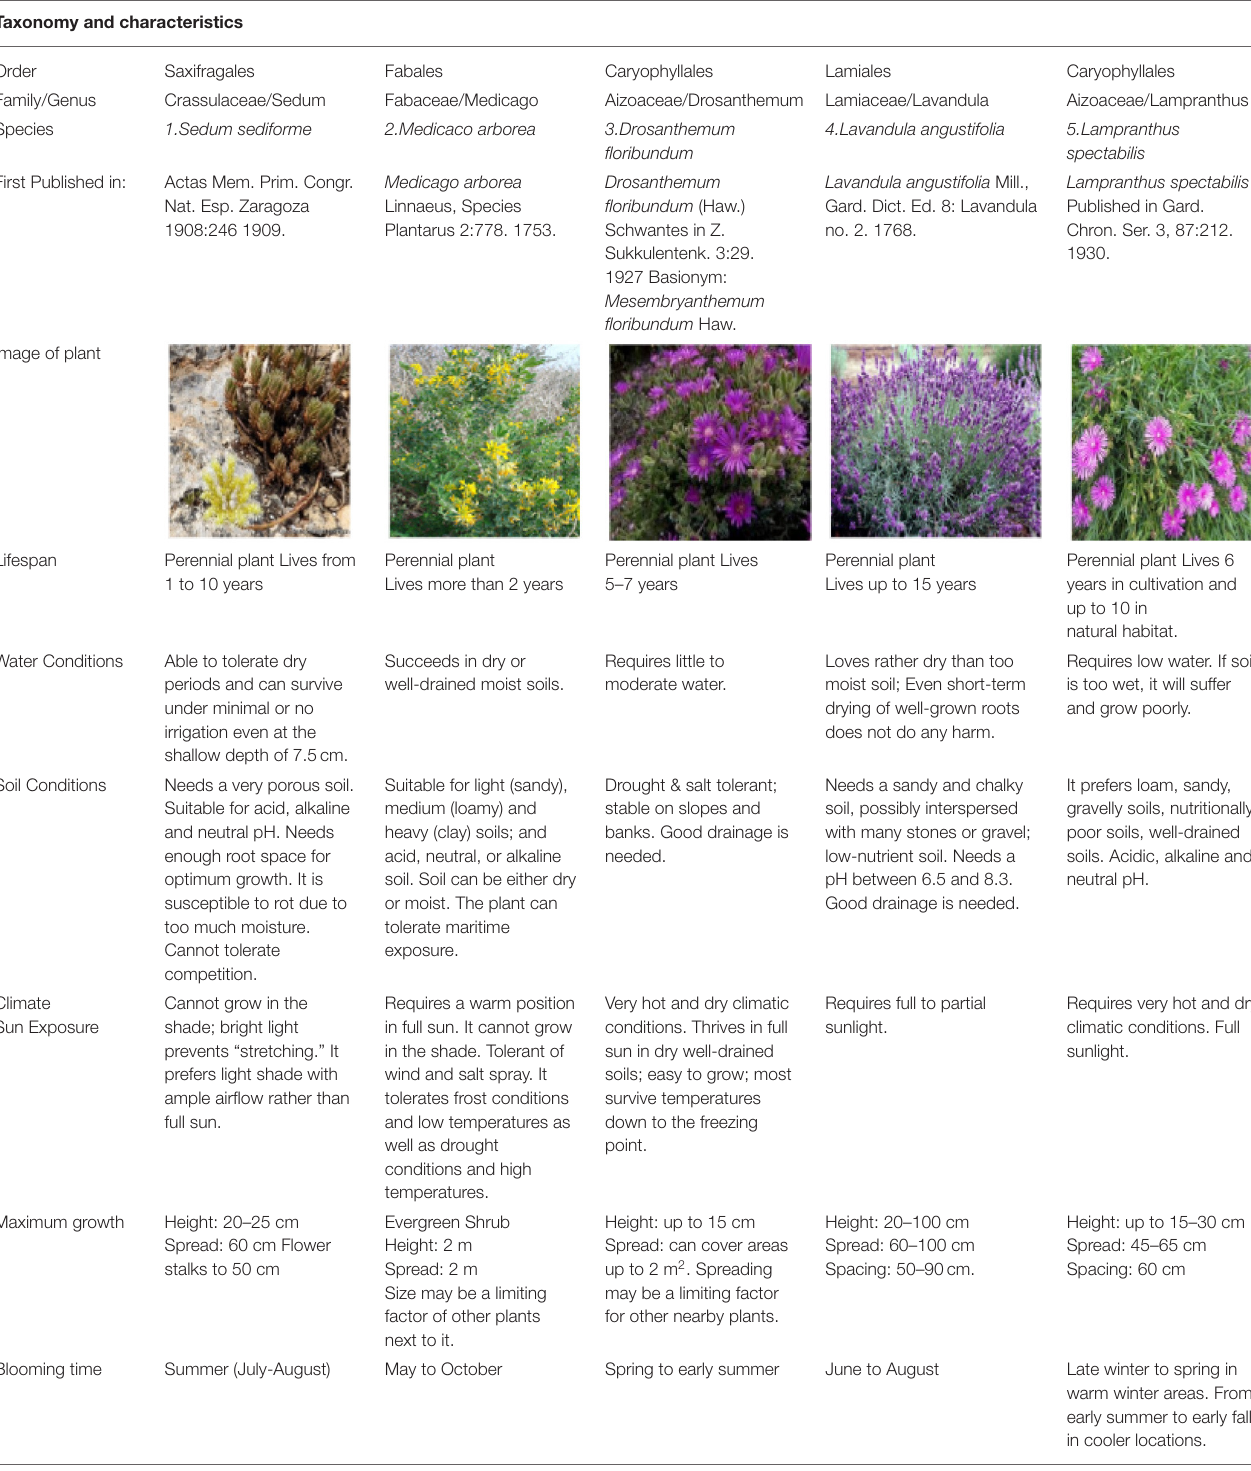
TABLE 1 | Selected plants and their